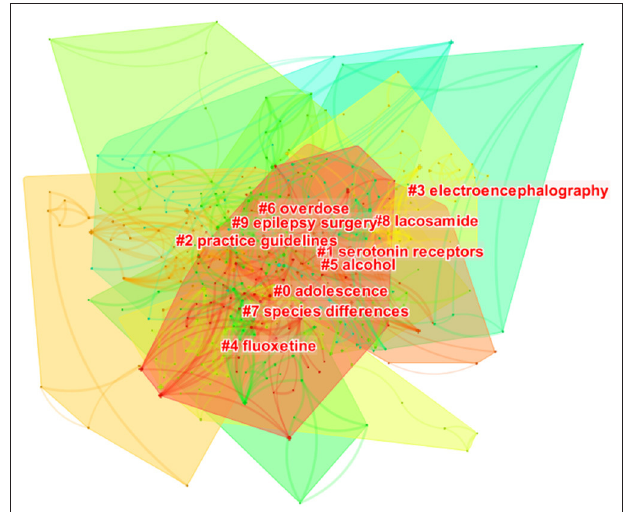
FIGURE 6 | Keywords cluster analysis co-occurrence